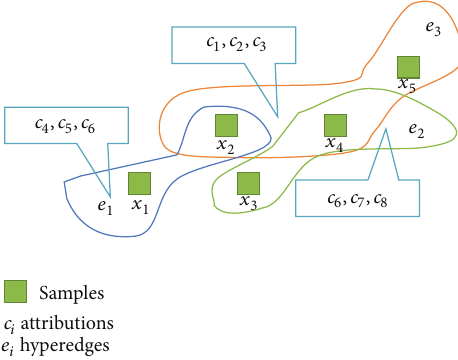
Figure 2: An example of neighborhood